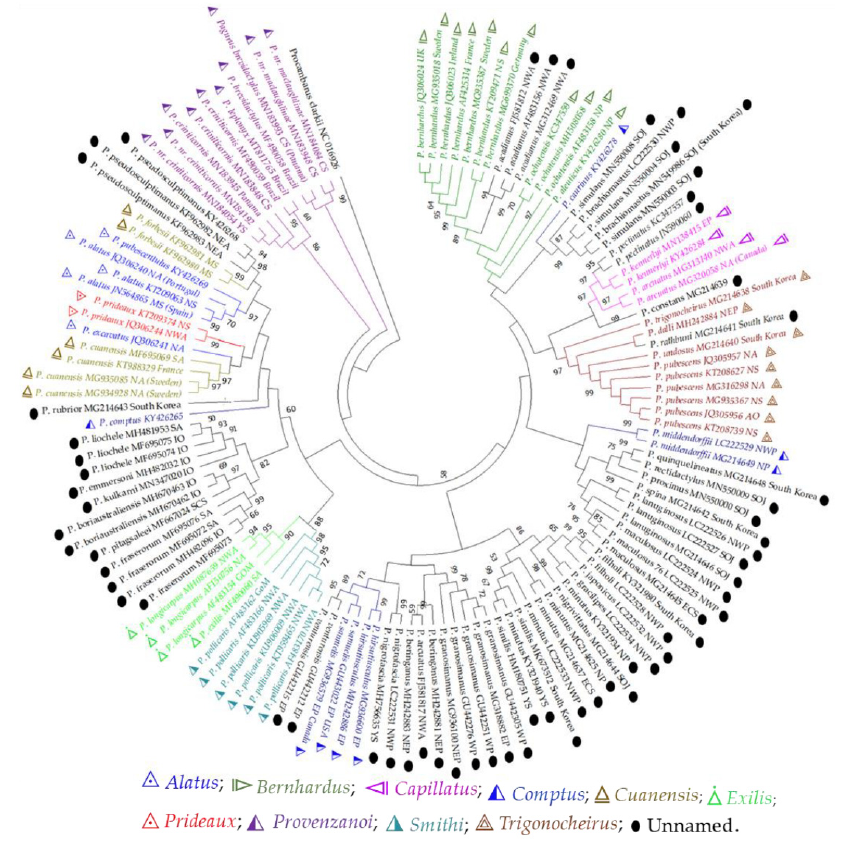
Figure 4. Phylogenetic tree of Pagurus species based on the COI sequence inferred with the maximum-likelihood (ML) method using GTR + G + I model. Branch lengths are proportional to inferred nucleotide substitutions. The species name, accession number and sampling location are shown for each sequence. Samples were collected from Arctic Ocean (AO), North Sea (NS), North Atlantic (NA), northeast Atlantic (NEA), northwestern Atlantic (NWA), Caribbean Sea (CS), Mediterranean Sea (MS), Gulf of Mexico (GoM), South Atlantic (SA), southwest Atlantic (SWA), North Pacific (NP), East Pacific (EP), northeast Pacific (NEP), northwest Pacific (NWP), southeast Pacific (SEP), Yellow Sea China (YSC), Yellow Sea South Korea (YSSK), East China Sea (ECS), South China Sea (SCS), Sea of Japan (SOJ), and Indian Ocean (IO). Different colors represent the morpho-based species groups. Consistent with other mtDNA marker phylogenies, species from the NWP regions were divided into several sub-clades with higher bootstrap support values. Pagurus filholi , P. japonicus , P. minutus , and P. similis were nested in a distinct clade with P. nigrivittatus . The taxonomic position of P. middendorffii , P. nigrofascia , and P. brachiomastus was incon- sistent among mtDNA markers (Figures 3, 4 and S1). Unlike 16S tree, species of the “ Comp- tus ” group clustered together, however, P. caurinus was isolated into different clade. An unassigned morpho-group species, P. venturensis showed genetic closeness with the “ Comptus ” group. To obtain more informative sites, the aligned sequences of 16S and COI were concat- enated for species with both markers. The phylogenetic tree obtained from the concate- nated sequences (Figure 5) had a better resolution of ancestral relationships among the morpho-based Pagurus groups, depicted by three monophyletic linages (L 1–3) with higher bootstrap support. These three major linages can be further divided into five clades (clade I–V), though some clades have low bootstrap supports (Figure 5). Consistent with